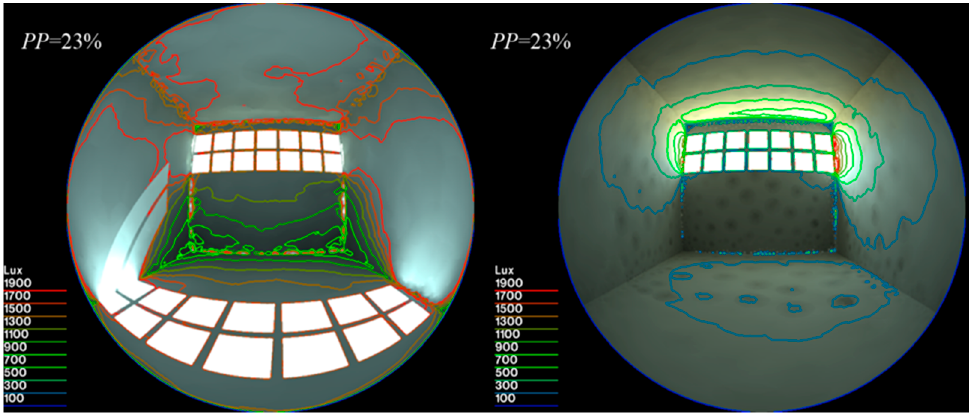
Figure 11. Radiance rendered views for a PP of 23% in the south- and the west-facing orientations at 12:00 p.m. 21 December (standard meteorological year).